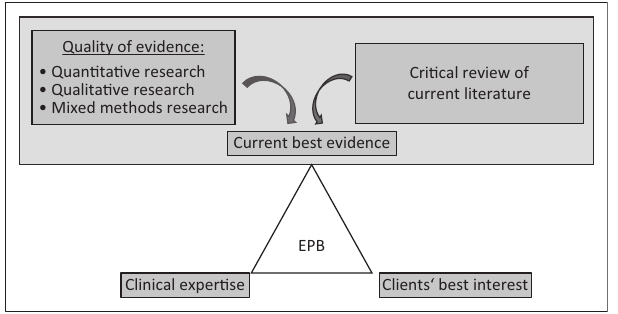
FIGURE 1: Evidence-based